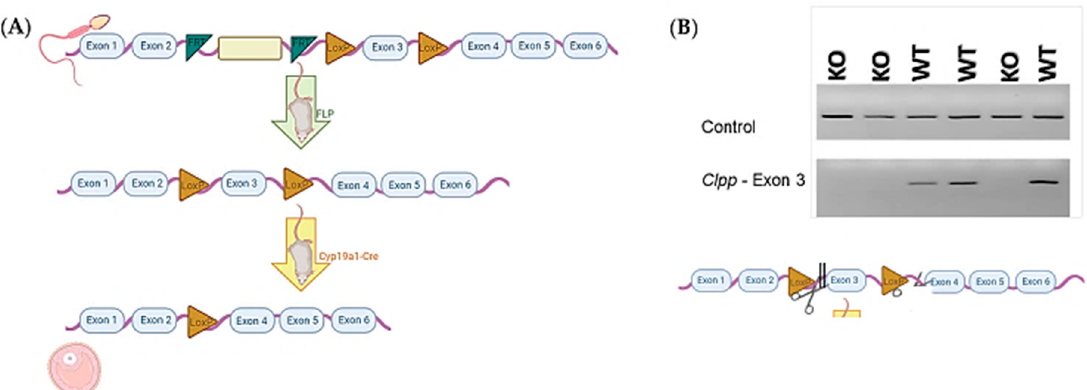
Figure 1. ( A ) Schematic illustration of the generation of mice with targeted deletion of Clpp in granulosa cells, using sperm with allele carrying reporter-tagged insertion. ( B ) Example of genotyping results from cumulus cells obtained from Clpp − / − and WT females ( n = 3 for each genotype), using polymerase chain reaction (PCR). The upper frame shows control using primers for a constitutively expressed mitochondrial gene Mfn2 . The lower frame shows the PCR product generated using primers upstream and downstream of exon 3, between the exon and LoxP.